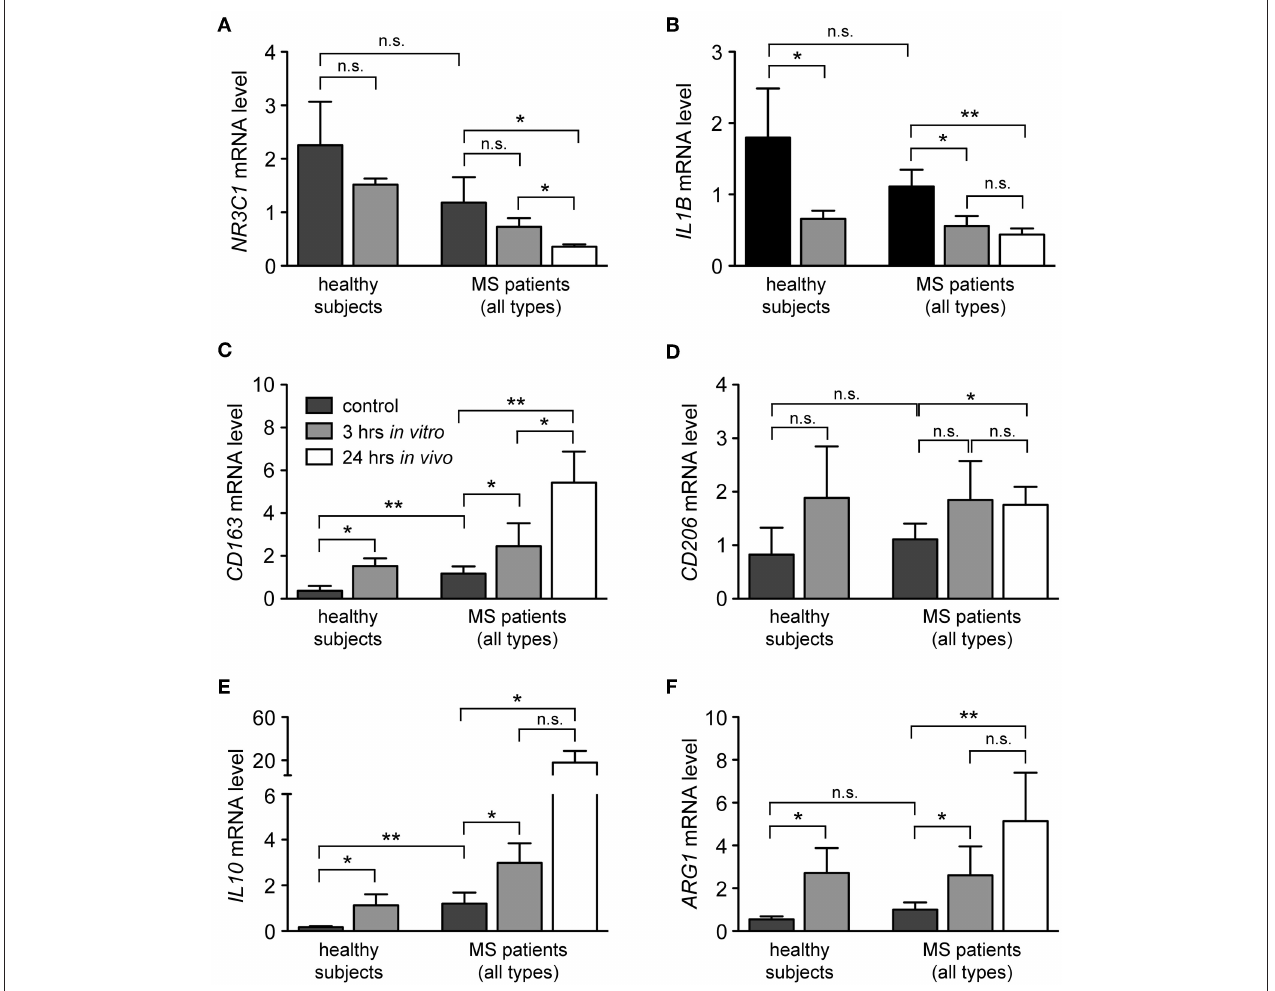
FIGURE 4 | Modulation of the phenotype of monocytes from healthy subjects and MS patients by GCs. Monocytes were isolated from the peripheral blood and cultured without (control) or with 10 − 6 M MP for 3h in vitro . A second blood sample was obtained from the same MS patients 24h after MP pulse therapy in vivo . Thereafter, RNA was prepared and analyzed by quantitative RT-PCR for mRNA levels of NR3C1 (A) , IL1B (B) , CD163 (C) , CD206 (D) , IL10 (E) , and ARG1 (F) . Gene expression was evaluated using the 11 Ct method and normalized to HPRT . Data are presented as the mean ± SEM; n = 6 (healthy individuals), n = 9 (MS patients). Statistical analysis was performed using a paired t -test ( IL1B , CD206) or a Wilcox matched-pairs signed rank test ( NR3C1, CD163, IL10, ARG1 ). Levels of significance: n.s. p ≥ 0.05; * p < 0.05; ** p <